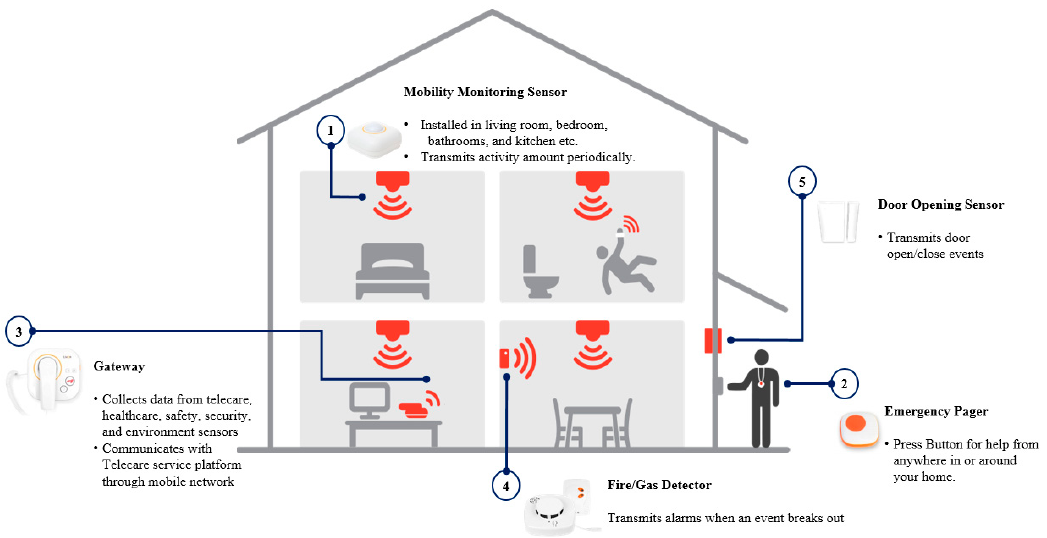
Figure 1. General features of the home mobility monitoring system